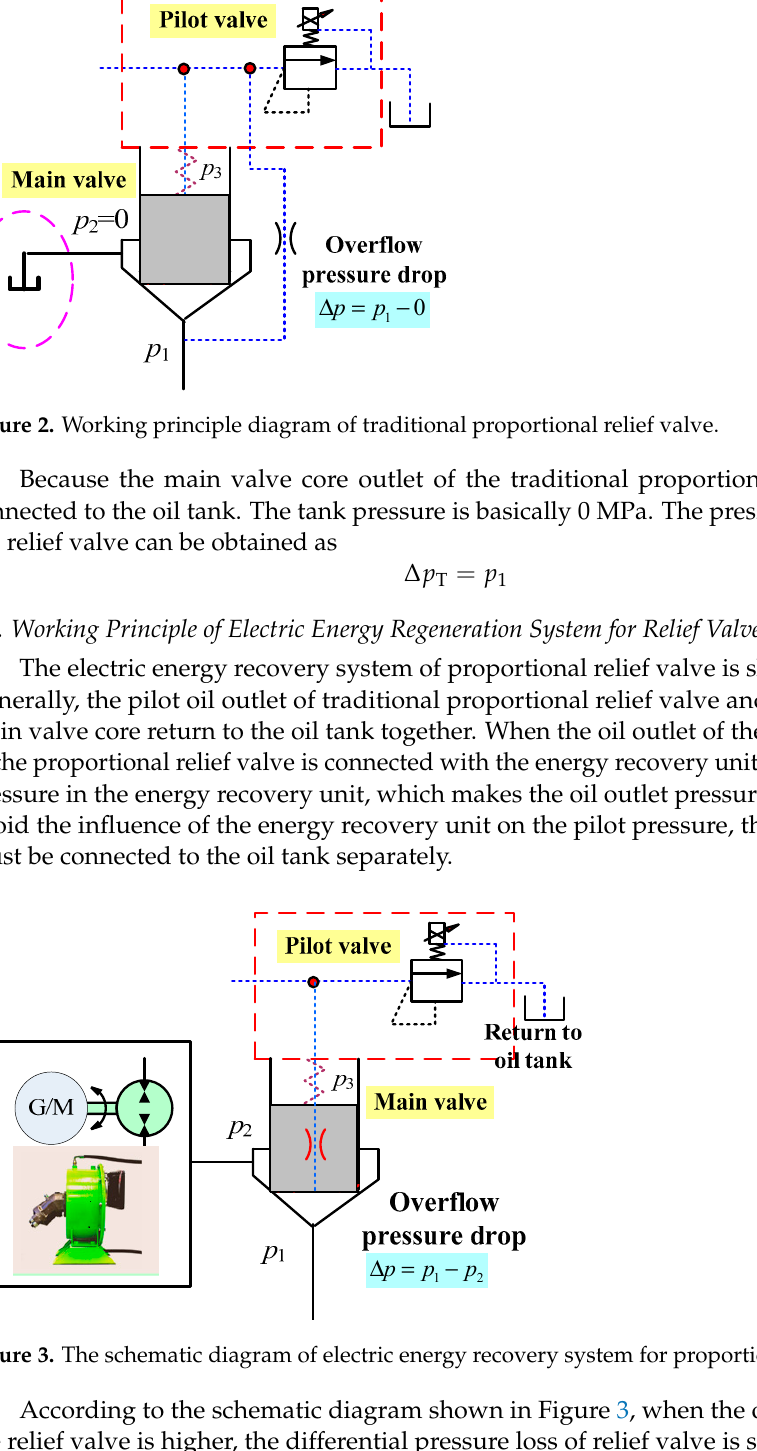
Figure 3. The schematic diagram of electric energy recovery system for proportional relief valve.